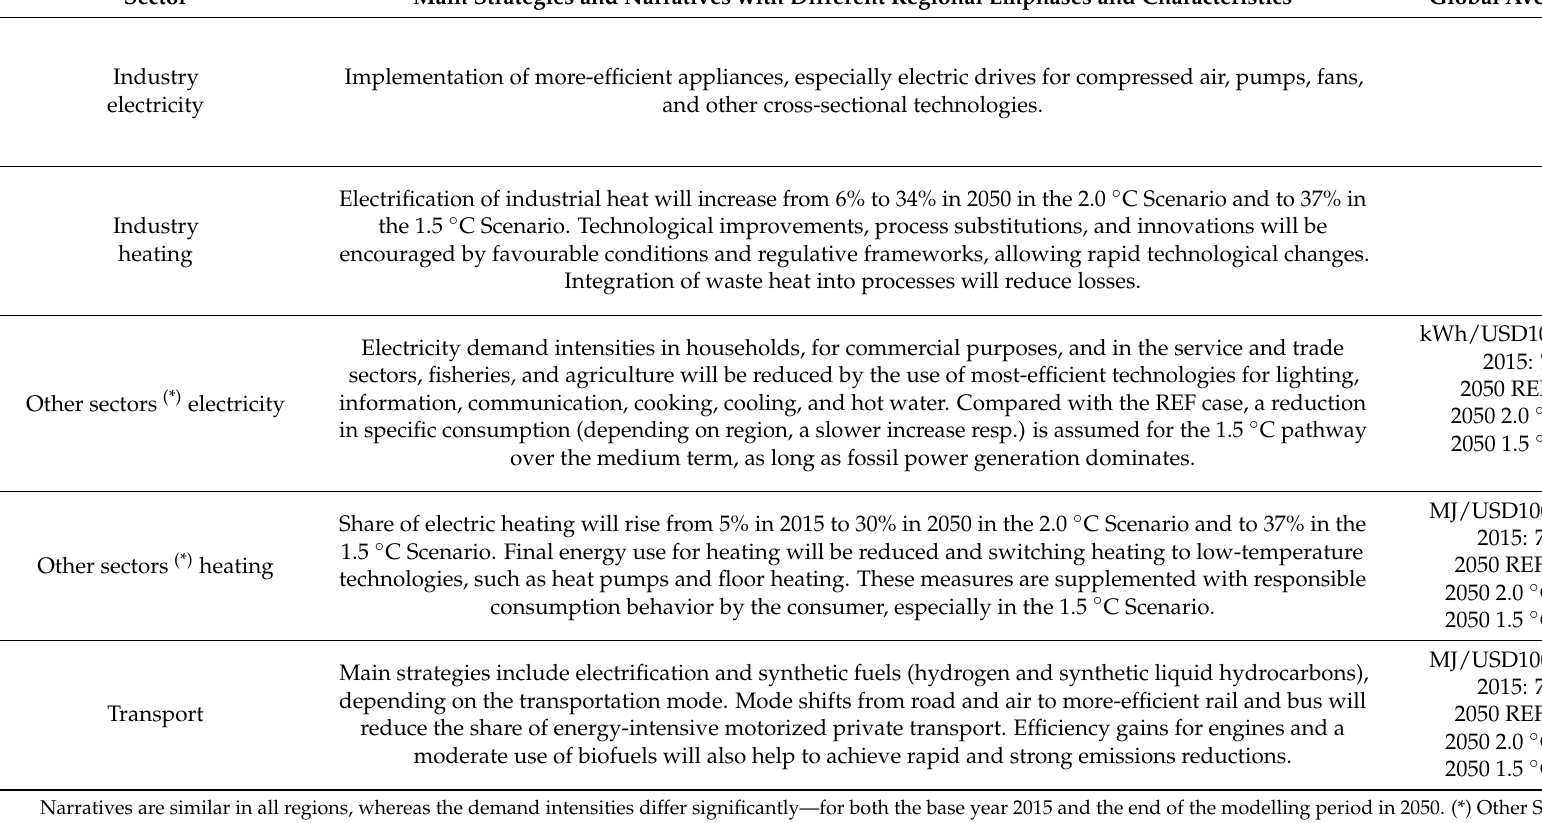
Table 1. Main strategies and narratives for all regions in each sector of the energy system for the 2.0 ◦ C and 1.5 ◦ C Scenarios compared with the Reference Scenario.